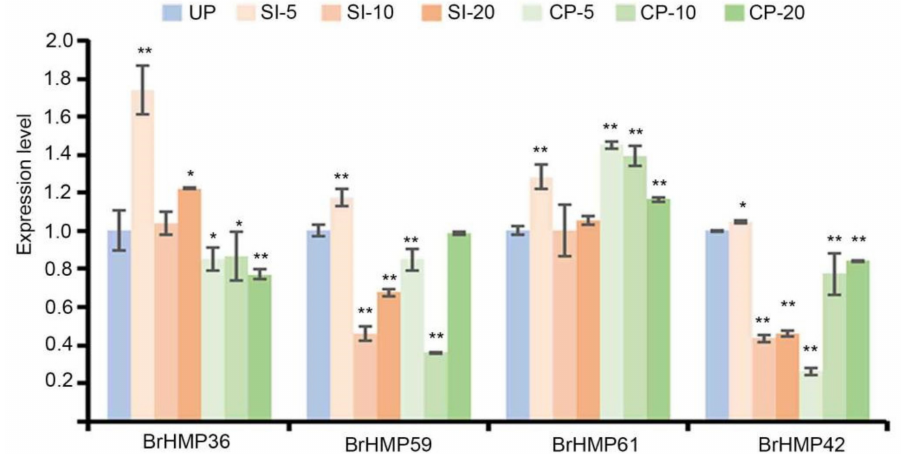
Figure 10. BrHMP gene expression profiles during SI and CP responses. Transcriptional level of four BrHMP genes at 5, 10, and 20 min after CP and SI pollination in the stigma. The experiments described above were carried out with UP as a control. UP (un-pollination), SI (self-incompatibility), CP (compatible pollination). The data are shown as mean ( ± SD), Student t test, * p < 0.05, ** p <